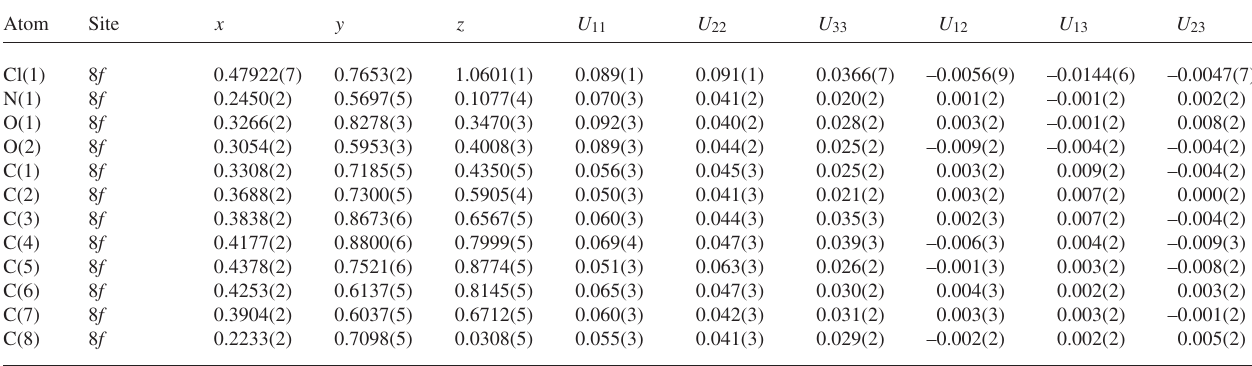
Table 3. Atomic coordinates and displacement parameters (in Å 2 )